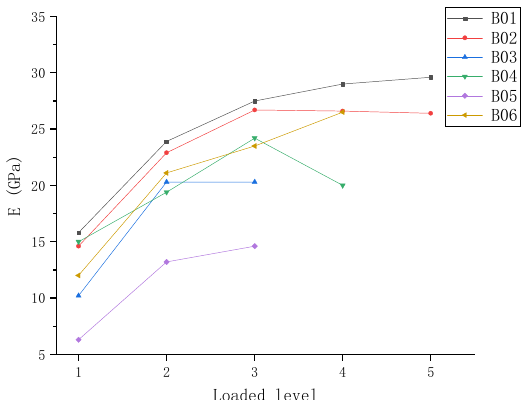
Figure 14. Relationship curve between rock sample cycle level and elastic modulus.